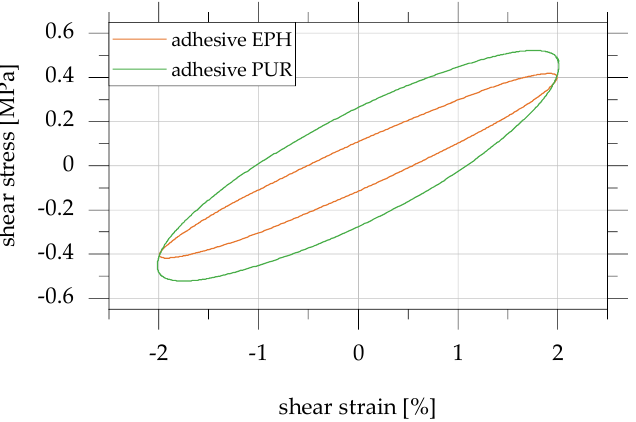
Figure 12. Analysis of the influence of the adhesive on the shear stress – shear strain hysteresis in test level A; exemplary representation for specimen configuration 2 with overlap length 20 mm for the test frequency 1 Hz for the adhesives EPH and PUR based on [22].